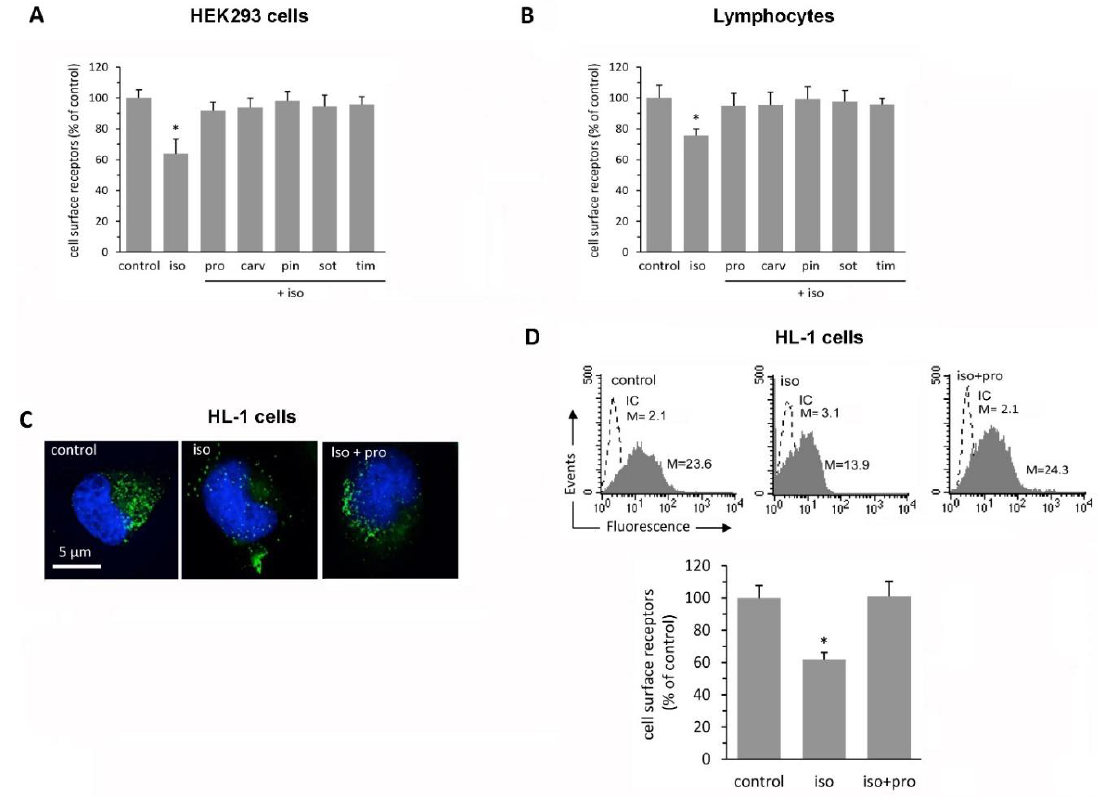
Figure 2. β-blockers restore cell surface β 2 -AR density after agonist-induced receptor downregulation. ( A ) Bar graph showing the effects of the β 2 -AR agonist isoproterenol on cell-surface β 2 -AR density. HEK293 cells stably expressing the N-terminal-FLAG-β 2 -AR were treated at 37 °C for 3 h with isoproterenol (iso) at the concentration of 1 μM. Isoproterenol caused receptor downregulation. This effect was completely antagonized upon adding β-AR antagonists. Data are means ± SEM from three independent experiments. Abbreviations as in Figure 1. * p < 0.05 vs. all other groups. ( B ) Bar graph showing the effects of the β 2 -AR agonist isoproterenol on the cell-surface β 2 -AR density of human lymphocytes. Isoproterenol caused receptor downregulation, but this effect was completely antagonized upon adding β-AR antagonists. Data are means ± SEM from three independent experiments. Abbreviations as in Figure 1. * p < 0.05 vs. all other groups. ( C ) Intensified video microscopy analysis after cell staining with anti-β 2 -AR antibody (green) and counterstained with Hoechst (blue) in HL-1 cells. Isoproterenol reduces β 2 -AR density, but the addition of propranolol to the culture medium reverses isoproterenol-mediated β 2 -AR downregulation. ( D ) Cytometric analysis of β 2 -AR density in HL-1 cells. Again, isoproterenol reduces β 2 -AR density, but propranolol antagonizes it. (upper panel) A representative experiment of quantitative evaluation of β 2 -AR density, after specific immunostaining, using flow cytometric analysis. M stands for median fluorescence intensity (MFI). Dashed line: cells plus isotypic immunoglobulines followed by secondary antibody. (lower panel) Bar graph showing cytofluorimetric results reported as mean ± SEM from three independent experiments and expressed as a percentage of the value obtained in untreated cells (control). * p < 0.05 vs. all other groups.